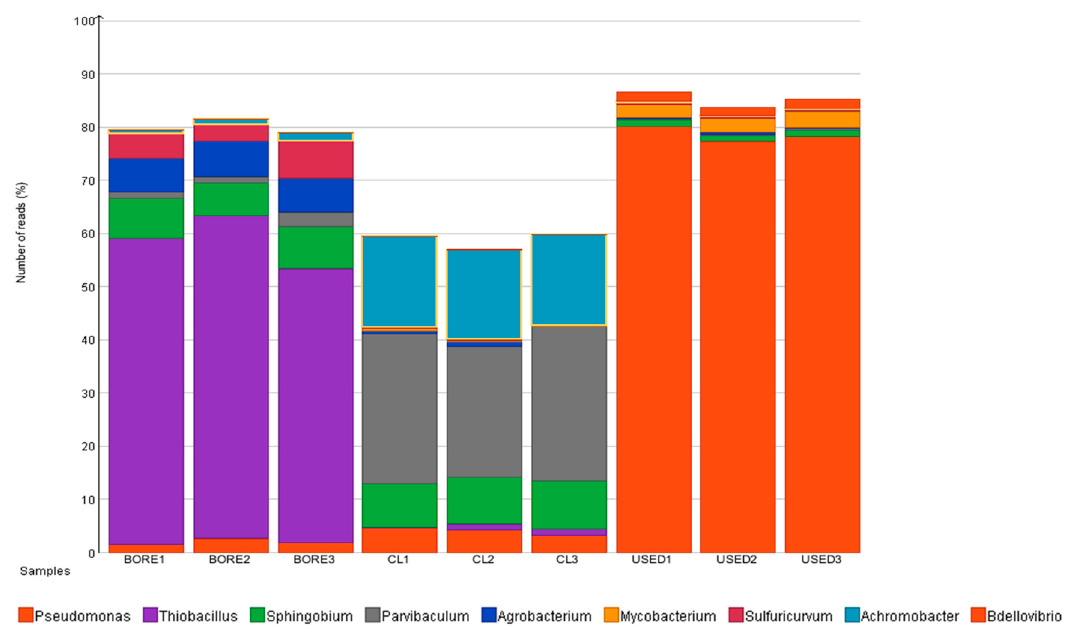
Figure 4. Microbial diversity (genus) in waters of the Peninsula hot springs. Borehole (Bore1–3) (44 °C), Chlorine treated (CL 1–3) and Post-bathing (Used 1–3) (percentage). Triplicates are shown.